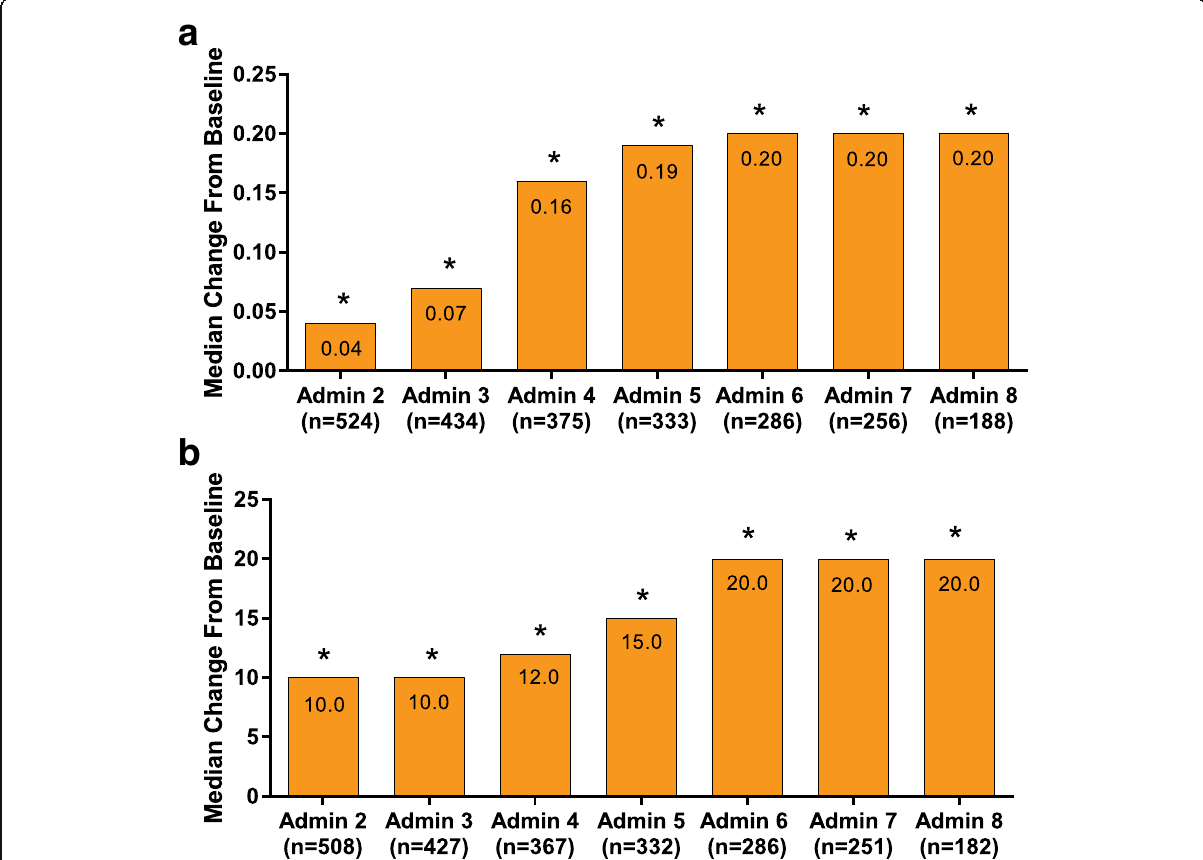
Fig. 4 Median change from baseline in EQ-5D total and health state score. a ) Median EQ-5D total score at baseline was 0.69; b ) Median EQ-5D health state score at baseline was 50.0. Both scores were evaluated at administration visit 2 through administration visit 8. † EQ-5D = EuroQol 5- Dimension Questionnaire. * P < 0.001 Wilcoxon signed rank test for change versus baseline (level of significance, 5%). † The numbers of patients in administration (Admin) visits 9 – 13 were as follows: Admin 9, n = 111; Admin 10, n = 47; Admin 11, n = 23; Admin 12, n = 12; Admin 13, n =